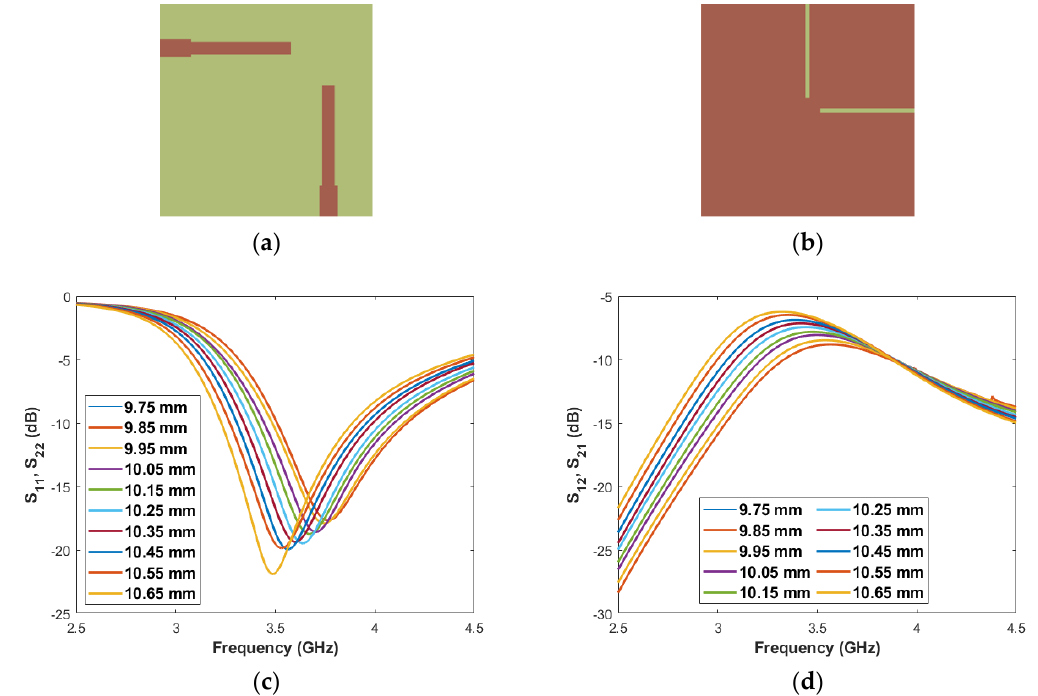
Figure 4. Antenna design after the slots is etched in the ground plane: ( a ) top view, ( b ) bottom view, ( c ) S 11 /S 22 , and ( d ) S 12 /S 21 results for different values of Ls.